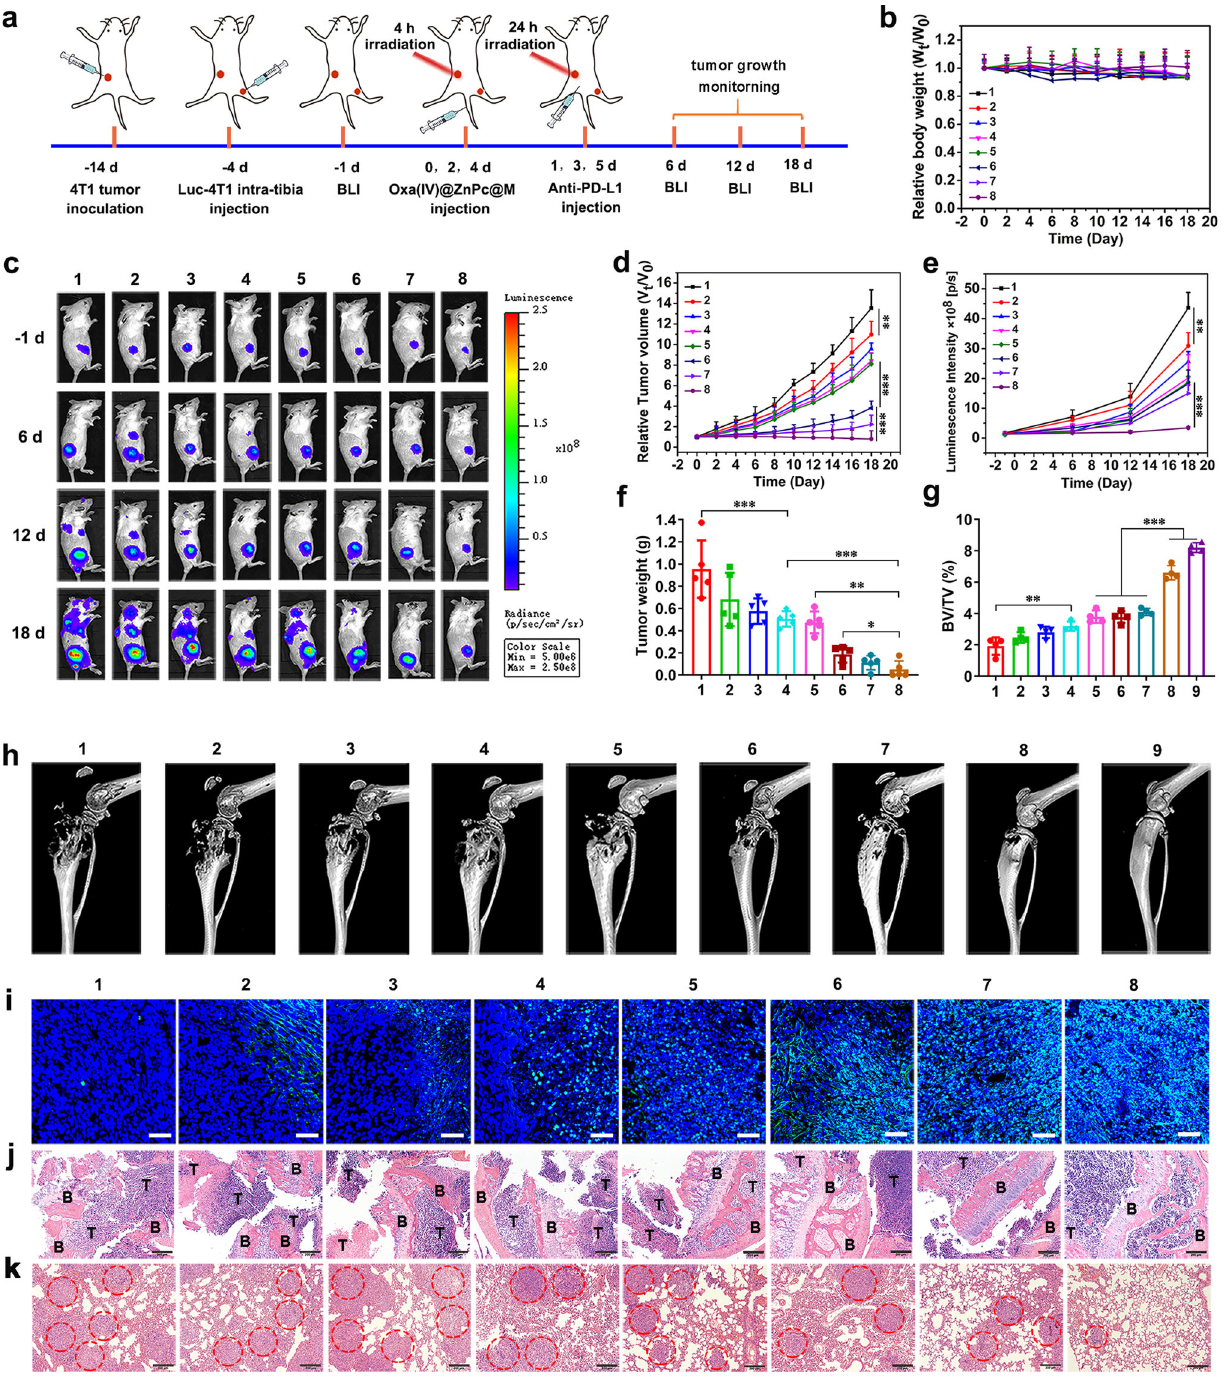
Fig. 6 Therapeutic ef fi cacy of Oxa(IV)@ZnPc@M combined with anti-PD-L1 for primary and bone metastatic breast cancer in 4T1-bearing mice. a Schematic illustration of experimental design. b Relative body weight after various treatments (1: PBS ( + ); 2: free Oxa; 3: Oxa(IV)@ZnPc; 4: Oxa(IV)@ZnPc@M; 5: BMMs + anti-PD-L1; 6: Oxa(IV)@ZnPc ( + ); 7: Oxa(IV)@ZnPc@M ( + ); 8: Oxa(IV)@ZnPc@M ( + ) + anti-PD-L1; 9: Normal, “ ( + ) ” represent laser irradiation, applied for all the antitumor studies in vivo) ( n = 5 individual animals). c Representative in vivo bioluminescence images tracking the growth of bone metastatic tumors. d Relative tumor growth curves of primary tumors ( n = 5 individual animals, ** p = 0.0098, *** p <0.0001, *** p = 0.0002). e Quantitative luminescence intensity curves of bone metastatic tumors ( n = 4 individual animals, ** p = 0.0024, *** p = 0.0005). f Average weight of ex vivo primary tumors ( n = 5 individual animals, *** p = 0.0006, *** p = 0.0005, ** p = 0.0013, * p = 0.0269). g The architecture parameters of BV/TV ( n = 4 technical replicates based on calculation parameters from one of the representative mouse of each group, ** p = 0.0015, *** p <0.0001). h 3D micro-CT reconstruction images of bone metastatic tibias. i TUNEL staining of the primary tumors. Scale bar = 50 µ m. j H&E staining of the tumor-bearing tibias and k the lung tissues, this experiment was performed one time. T represents tumor and B represents bone. Red circle represents tumor metastatic area. Scale bar = 200 µ m. All data were presented as mean±SD. Statistical signi fi cance was evaluated via one-way ANOVA with a Tukey ’ s test d , f , g or Dunnett ’ s test e . * p <0.05, ** p <0.01, *** p <0.001. Source data are provided as a Source data fi le.